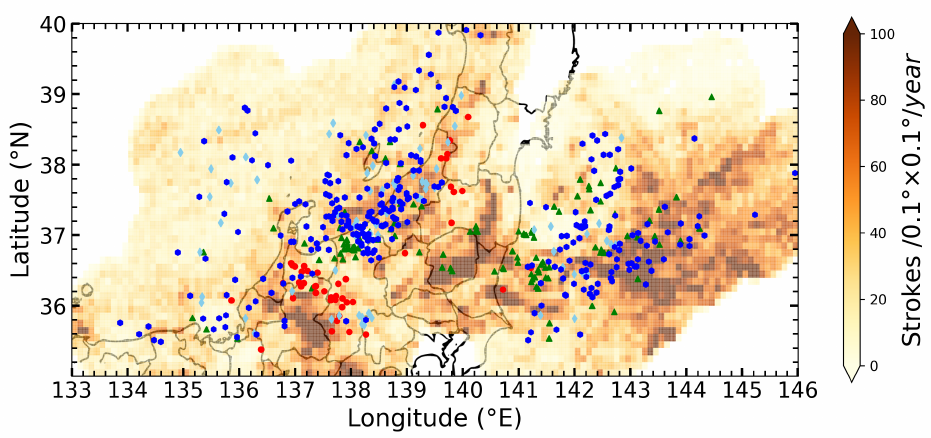
Figure 3. Location map of 537 sprites from September 2016 to February 2022 in different seasons observed by ASCA. Spring, summer, autumn, and winter are represented by green triangles, red dots, light blue diamonds, and blue dots, respectively. Lightning distribution within 100 km from the detected sprites is shown as a brown contour. The background map is provided by Geospatial Information Authority of